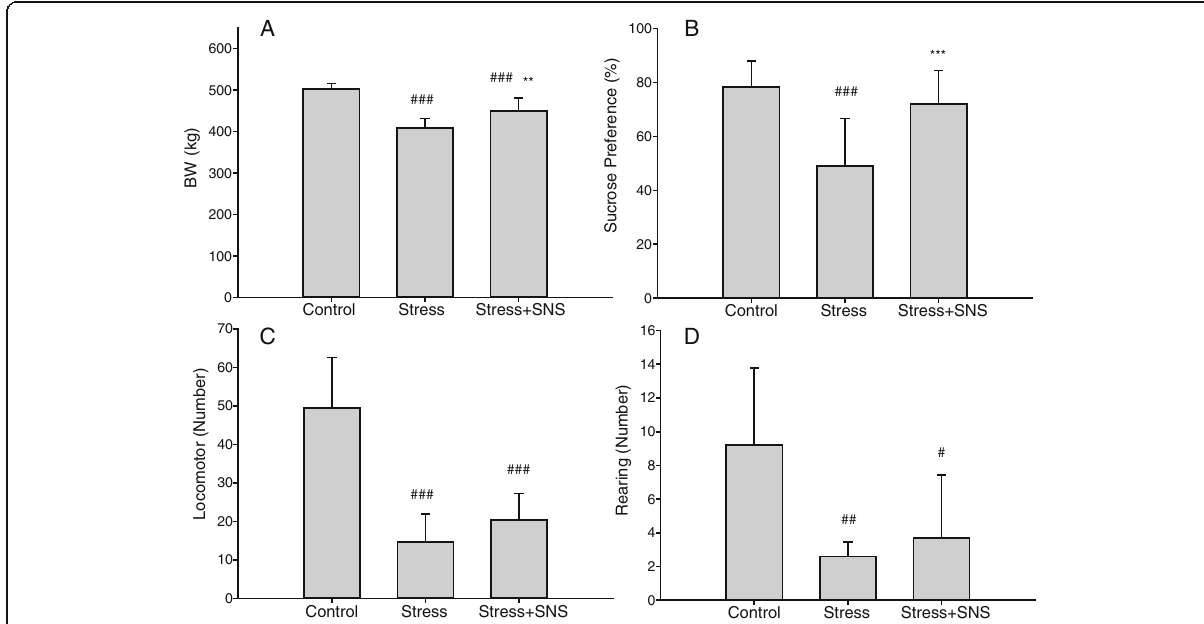
Fig. 2 Changes in behavioral indicators after the chronic restraint stress (CRS) procedure and Sinisan (SNS) treatment. a Body weight (BW) changes after CRS. b The sucrose preference after the CRS procedure and SNS treatment. c , d Open-field test indexes (the number of locomotor and rearing events) after the CRS procedure and SNS treatment. Values plotted are mean ± standard deviation ( N = 10 per group). # p < 0.05, ## p < 0.01, ### p < 0.001 versus the control group, ** p < 0.01, *** p < 0.001 versus the stress group